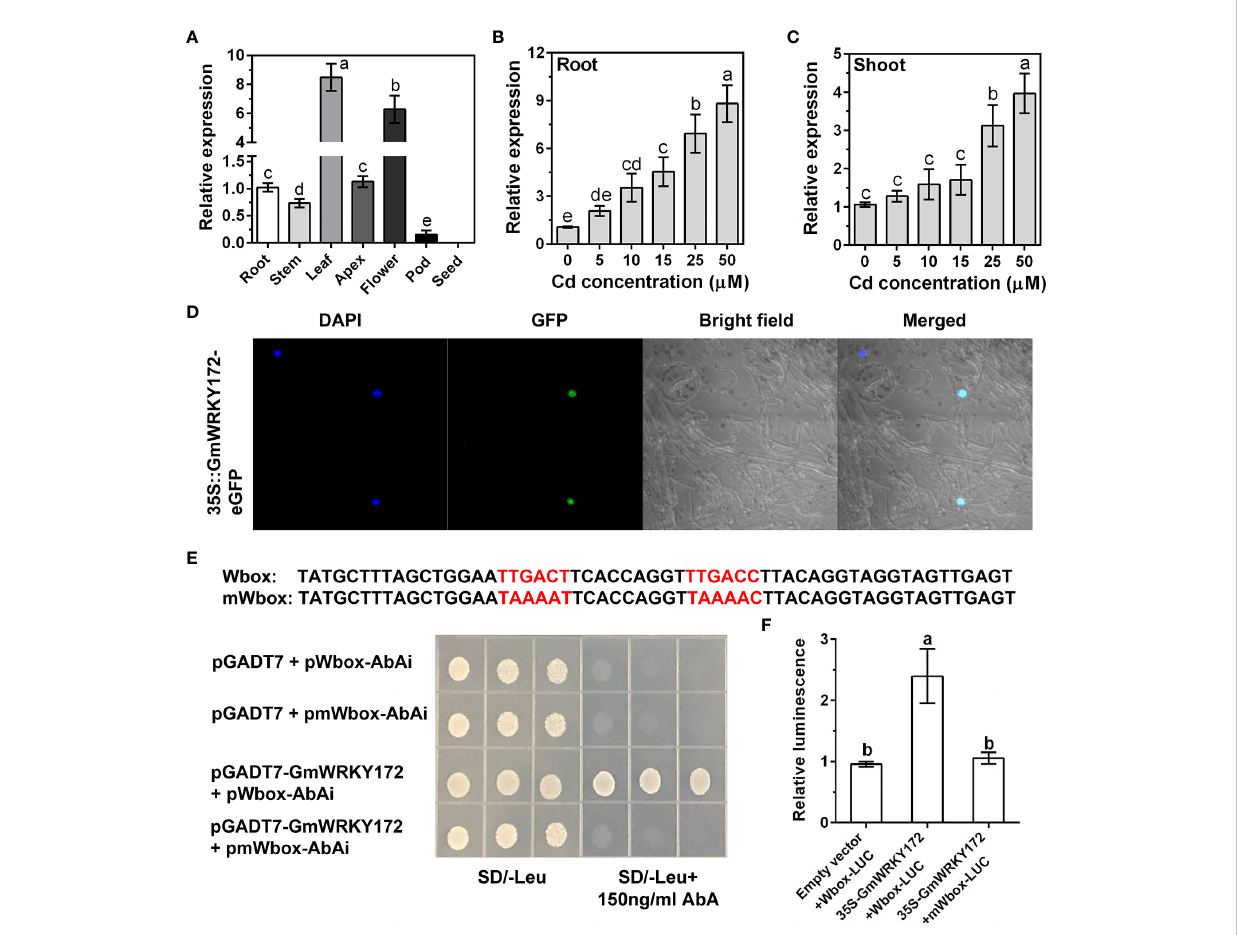
FIGURE 1 Expression patterns, subcellular localization, and transcriptional activity assays of GmWRKY172. (A) Expression analysis of GmWRKY172 in different tissues of soybean by quantitative reverse transcriptase PCR (qRT-PCR). Dose-dependent expression of GmWRKY172 in roots (B) and leaves (C) . Samples were exposed to different Cd concentrations (0, 5, 10, 15, 25 and 50 µM) for 4 hours. (D) Subcellular localization of GmWRKY172 in Nicotiana benthamiana epidermal cells. (E) Yeast one-hybrid analysis for interaction between GmWRKY172 and W-box motifs. The Y1HGold yeast strain was co-transformed with the prey (pGADT7 or pGADT7-GmWRKY172) and the bait (pAbAi-Wbox or pAbAi-mWbox). SD medium lacking leucine with 150 ng/mL AbA was used to determine the interaction between the bait and prey proteins. (F) Transcription activity assay in Nicotiana benthamiana to examine the interaction between GmWRKY172 and W-box motifs. The relative luminescence was determined by normalizing fi re fl y luciferase activity with Renilla luciferase activity. Data are expressed as mean ± SD ( n = 3). Different letters indicate statistical signi fi cance determined by one-way analysis of variance and Duncan ’ s test ( P ≤